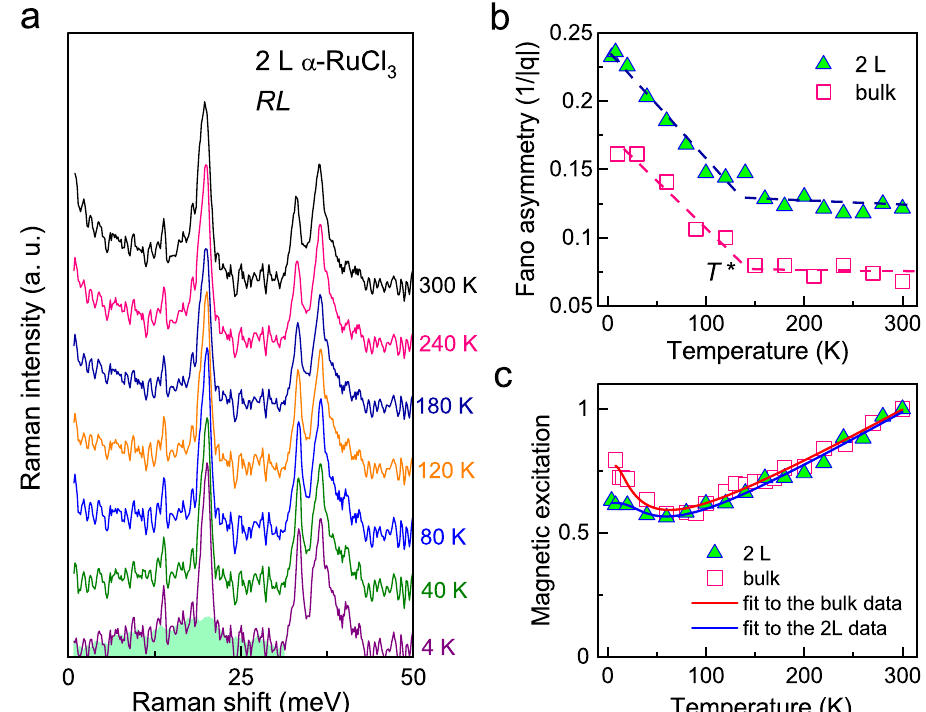
Fig. 2 Comparison of the Raman spectra between the bulk and bilayer α -RuCl 3. a Raman spectra of bilayer α -RuCl 3 at selected temperatures. The spectra are vertically shifted for clarity. b Temperature dependence of the Fano asymmetry for the bulk and bilayer α -RuCl 3 . The dashed lines are guides to the eye. c Temperature dependence of the integrated Raman intensity over the middle energy of ω = 8.4 − 16.1 meV for the bulk and bilayer α -RuCl 3 . The solid lines fi t to a sum of the two-fermionic and bosonic